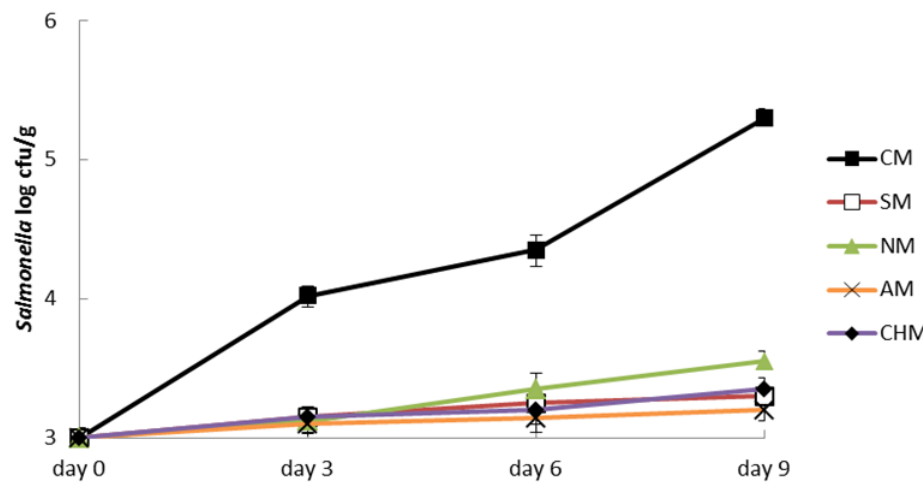
Figure 1. Changes in S. Typhimurium CECT 4594 inoculated in minced meat during storage at 4–6 °C. Control meat (CM), sodium meat (SM), nitrite meat (NM), sodium acetate meat (AM), sodium acetate–chitosan meat (CHM).